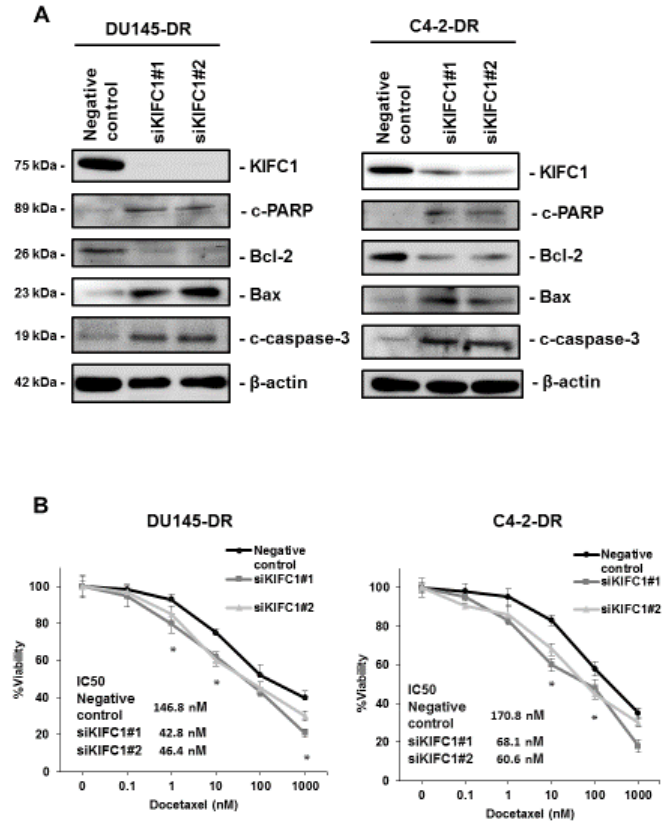
Figure 3. Inhibition of KIFC1 induces an apoptosis pathway and reverses docetaxel (DTX) resistance in vitro. ( A ) Western blotting of KIFC1, c-PARP, Bcl-2, Bax, and c-caspase-3 in DU145-DR and C4-2-DR cells transfected with a negative control or two different siRNAs for KIFC1. β -actin was used as a loading control. c-PARP: cleaved PARP; c-caspase-3: cleaved caspase-3 ( B ) The dose-dependent effects of DTX on the viability of DU145-DR and C4-2-DR cells transfected with negative control or two different siRNAs for KIFC1. The results are expressed as the mean and S.D. of triplicate measurements. * p < 0.01.